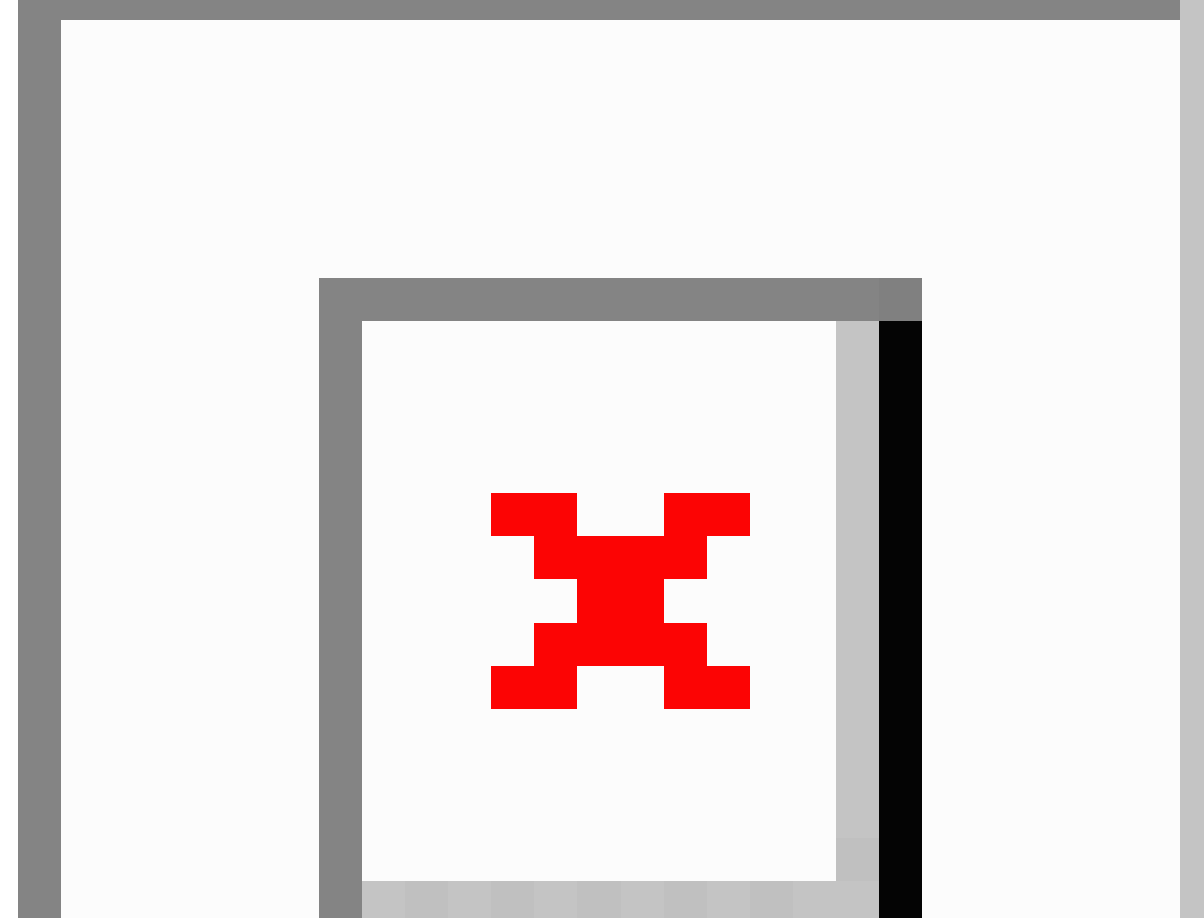
Figure 2. Distribution of scores on the Patient Health Questionnaire (PHQ-9) from those participants screened through Google advertising. Subthreshold depression scores for participants eligible for inclusion in the Mood Memos study ranged from 3 to 17 on the